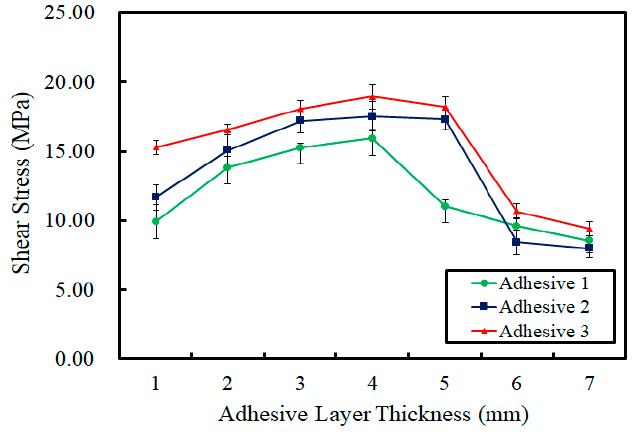
Table 2. Maximum Shear Stresses (Unit: MPa).